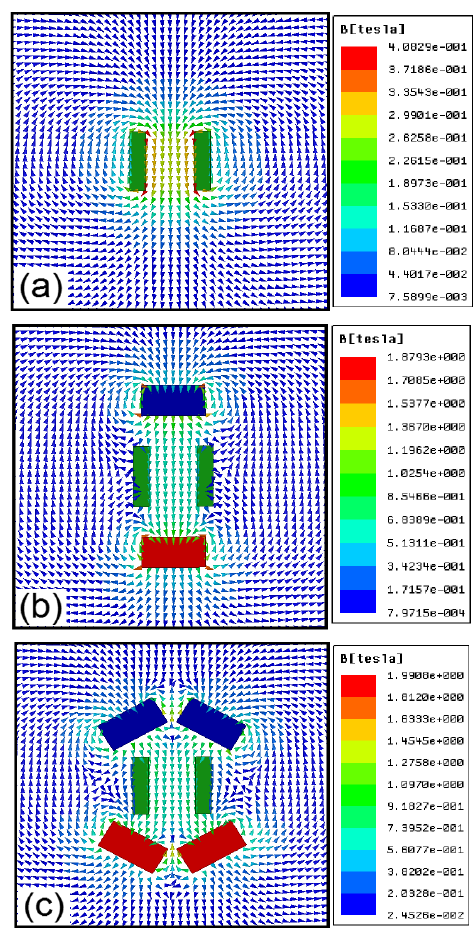
Figure 10: Magnetic flux density for: (a) Conventional railgun. (b) Augmented railgun with 2 magnets. (c) Augmented railgun with 4